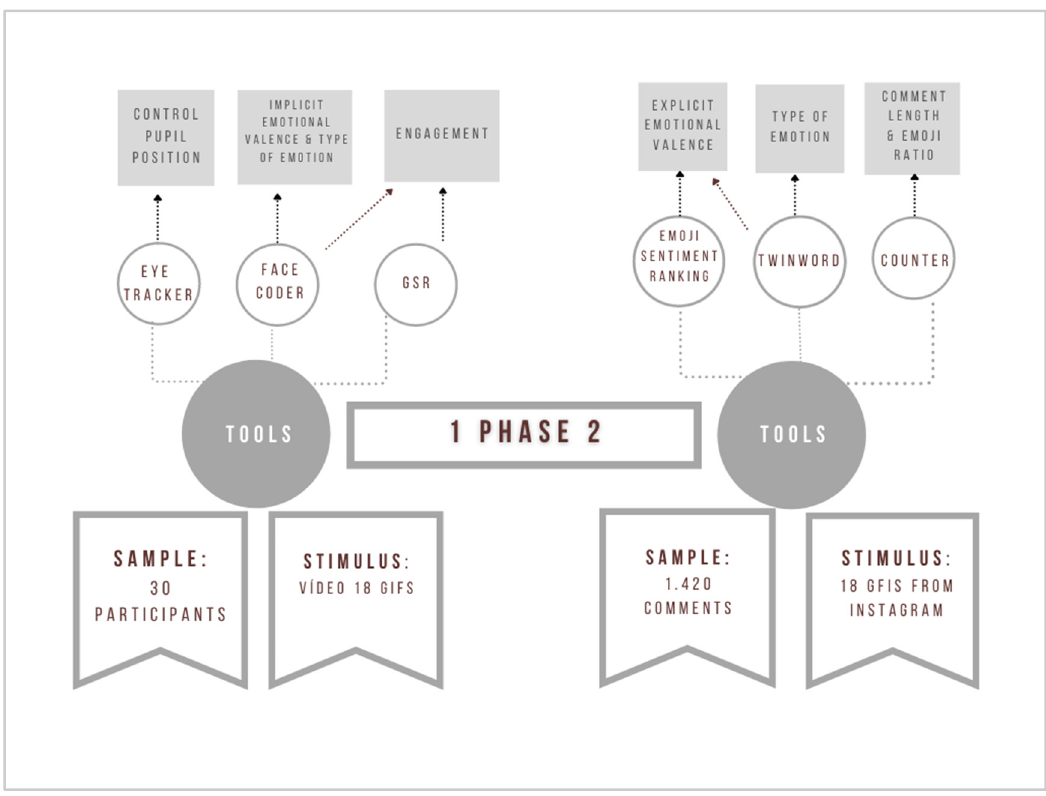
Figure 1. Visualization of the methodology of phases 1 and